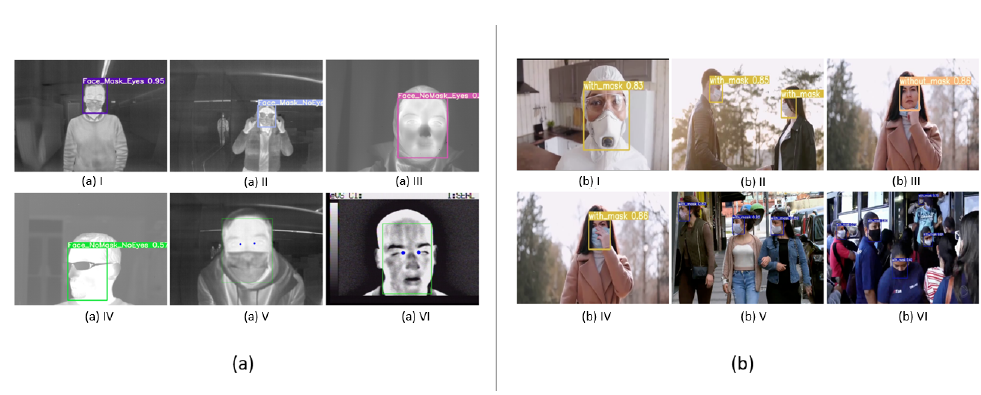
Figure 11. ( a-I - a-VI ) Examples of results obtained in images, from inference of selected algorithms for mask and glasses detection components and detection of zone corresponding to human caruncle. ( b-I - b-VI ) Examples of results obtained in images, from inference of selected YOLOv5 algorithm for mask